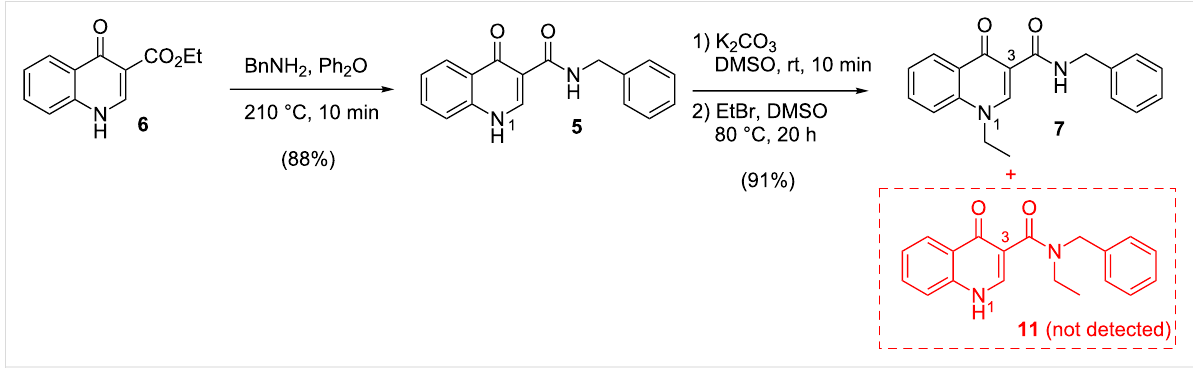
Scheme 1: Synthetic route for the preparation of 1-ethyl-4-oxoquinoline-3-carboxamide 7 .